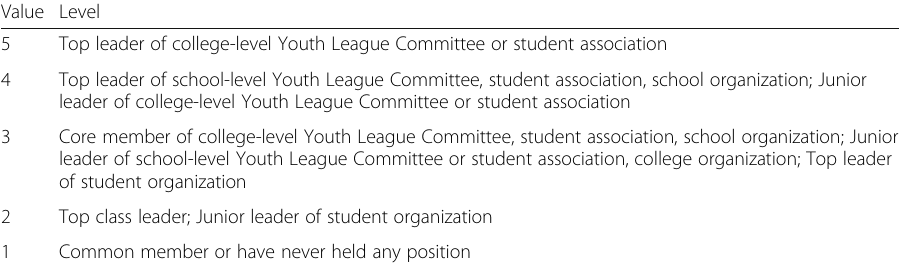
Table 1 Student leadership levels and